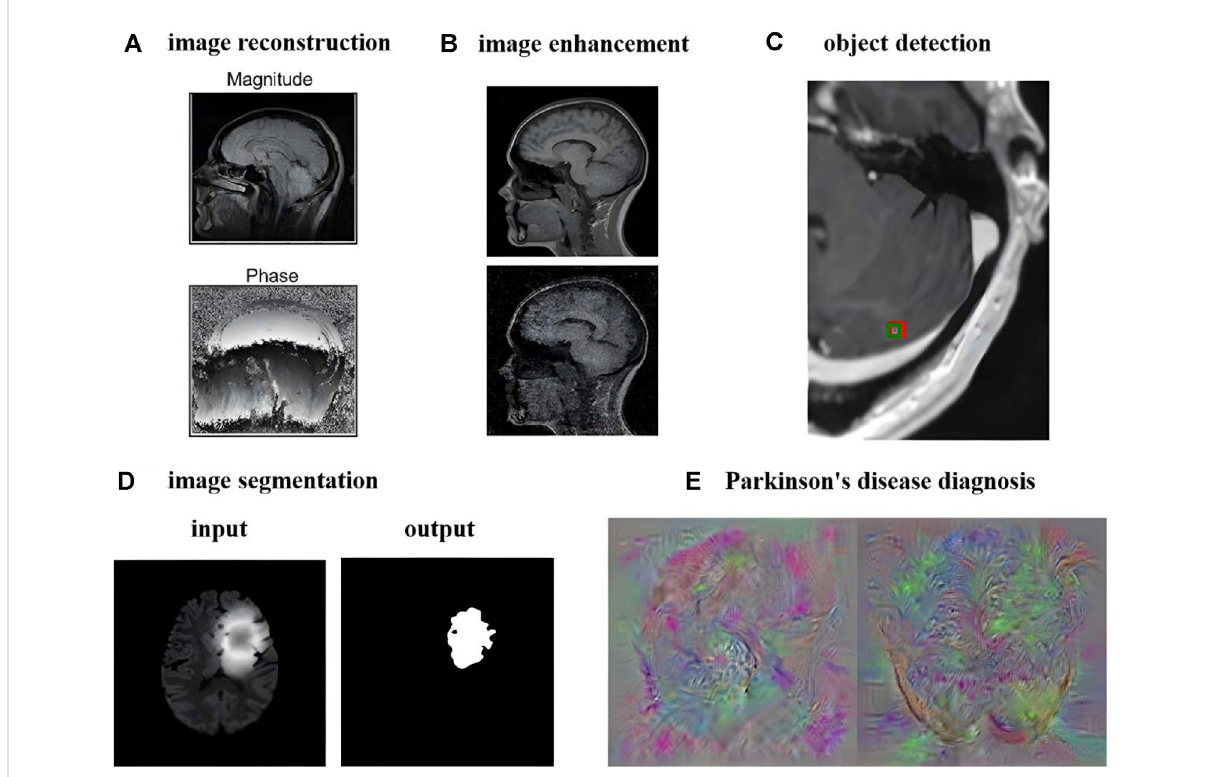
FIGURE 7 DeepLearningImageProcessingandAnalysisUsingBrainMRIasanExample. (A) ImagereconstructionofbrainMRI(adaptedandmodi fi edfrom Lundervoldetal.,2019). (B) ImagedenoisingofbrainMRI(adaptedandmodi fi edfromLehtinenetal.,2018). (C) Smallestbrainmetastasisdetectedby arti fi cial intelligence method marked with red bounding box (adapted and modi fi ed from Zhang et al., 2020). (D) Brain Tumor Segmentation Using UNet++ (adapted and modi fi ed from Zhou et al., 2020). (E) Feature images extracted by Parkinson ’ s diagnostic network (adapted and modi fi ed from Sivaranjini et al.,